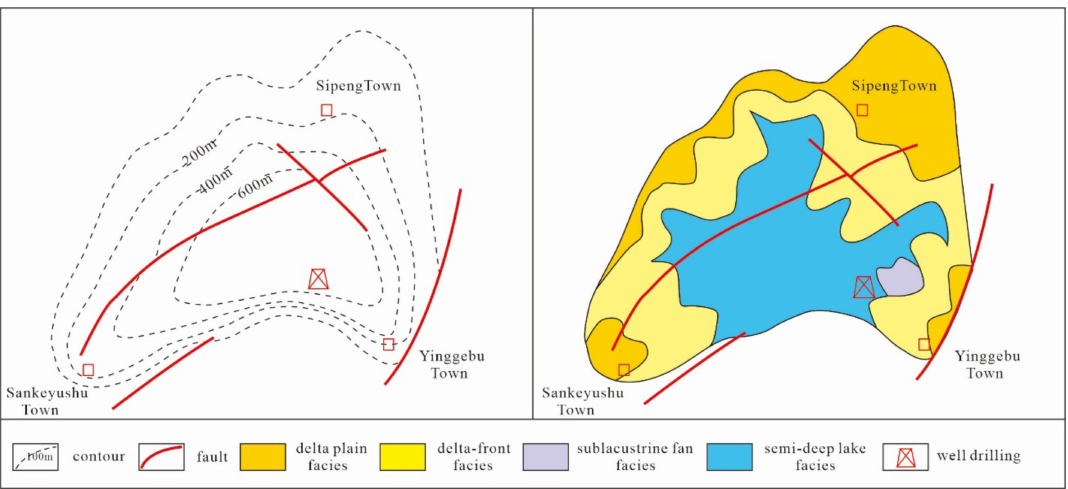
Figure 2. Stratum thickness map and sedimentary facies distribution map of the Hengtongshan